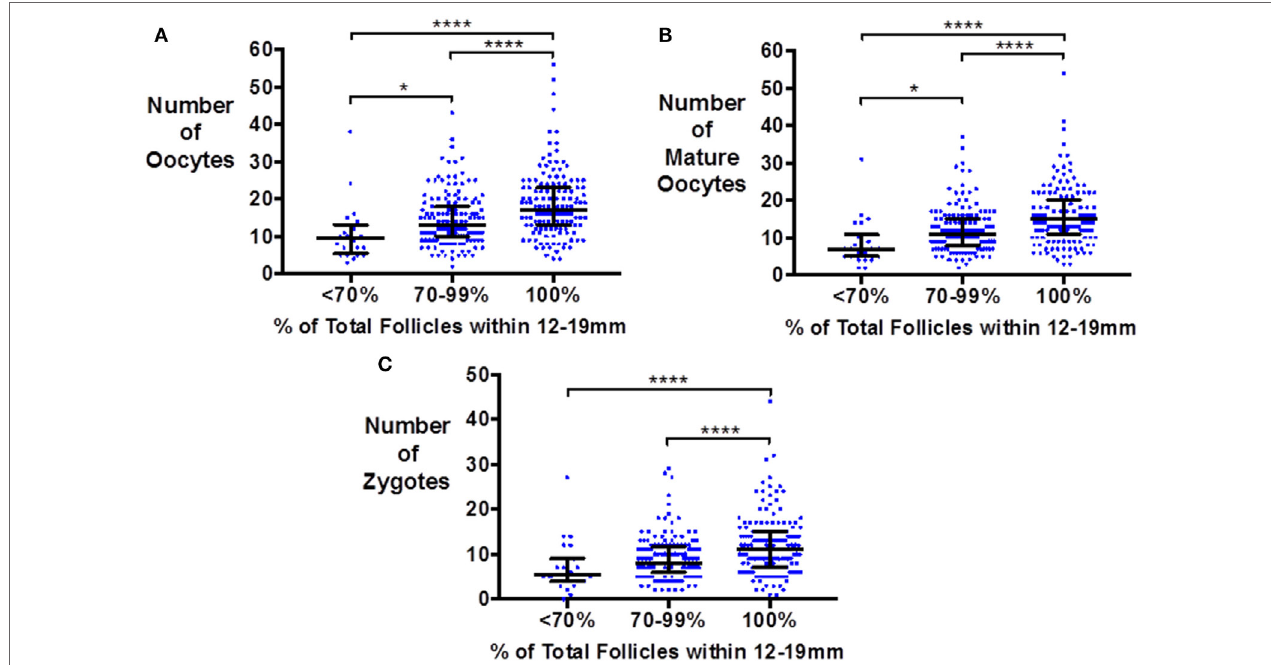
FigUre 1 | Scattergram (median and interquartile range) of the number of oocytes (a) , mature oocytes (b) , and zygotes (c) by the proportion of follicles on the day of trigger within the size range 12–19 mm in patients triggered with either hCG or GnRH agonist. Groups are compared by the Kruskal–Wallis test with post hoc Dunn’s correction for multiple comparisons (* P < 0.05 and **** P < 0.0001).